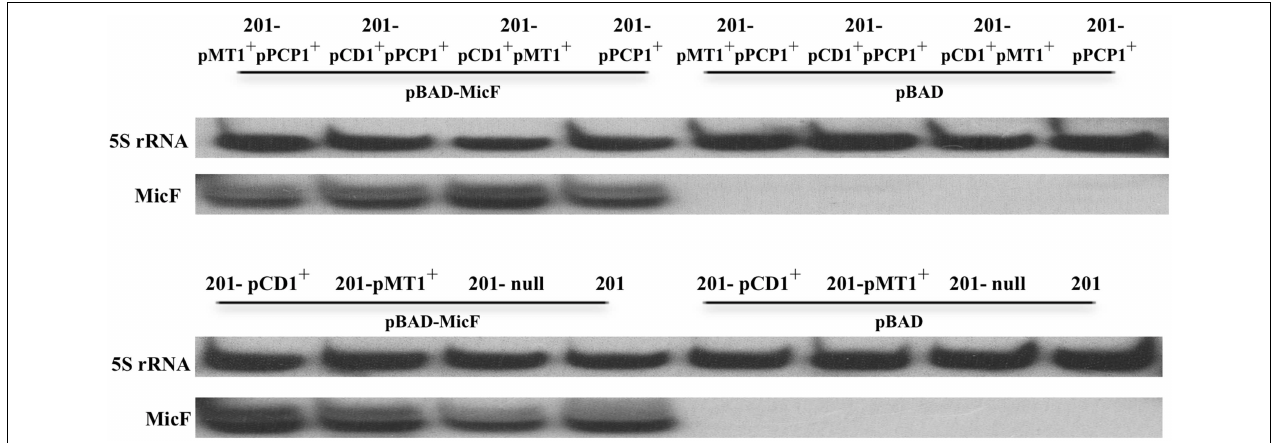
FIGURE 3 | Detection of MicF expression in various strains of Y. pestis . MicF expression detected by Northern Blot, in which 5S rRNA images from each tested strain were provided as control.